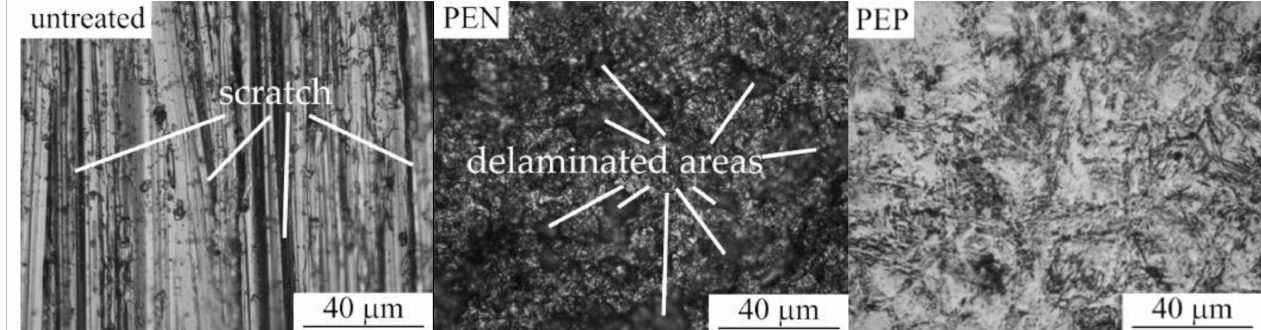
Figure 5. Surface morphology of untreated steel and after PEN as well as with subsequent PEP in ammonium chloride (3%) solutions under forced circulation of electrolyte at 300 V and 80 ◦